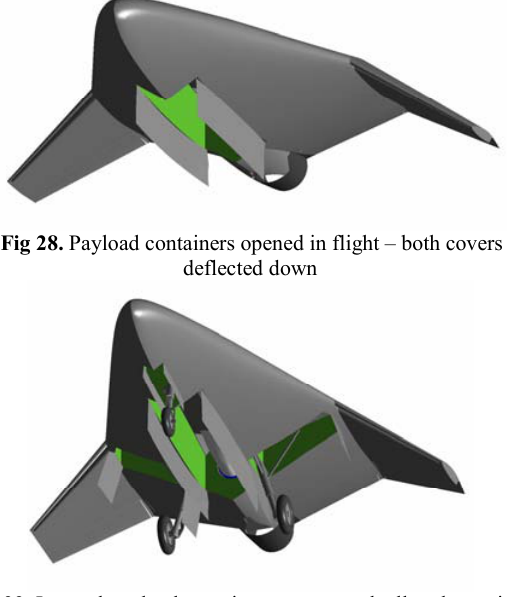
Fig 29. Internal payload containers are opened, all undercarriage legs deflected down. Double covers of each undercarriage containers are visible Fig 33. Clean configuration from a top-front-side view. Flight